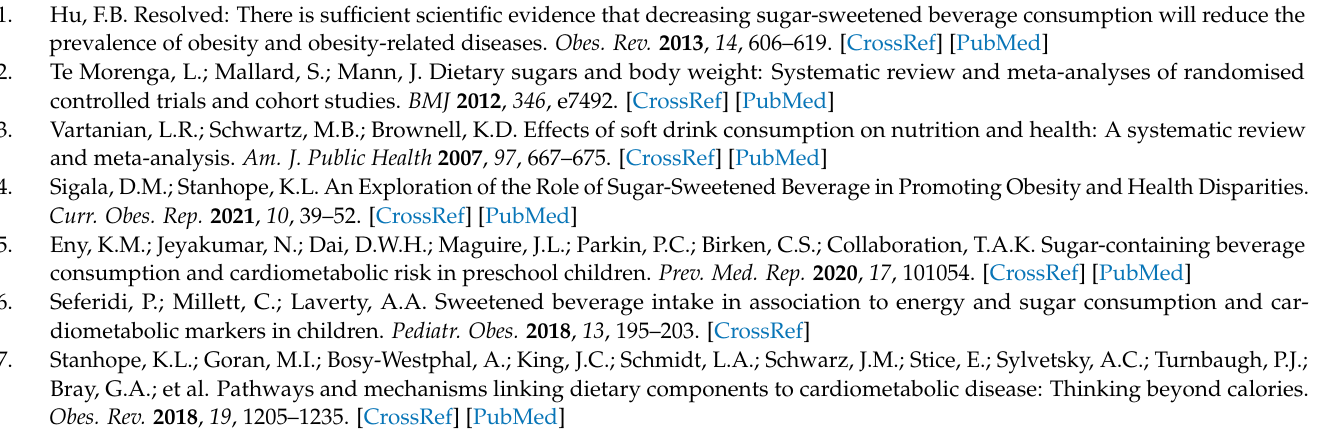
Table S1: Means and standard deviations for the cardiometabolic measures of interest at each visit in childhood and adolescence, Table S2: Prospective associations between all 180 metabolites associated with sugar sweetened beverage intake in childhood (from step 2) and fasting triglycerides across childhood and adolescence, Table S3: Sensitivity Analysis—Prospective associations between select metabolites associated with sugar sweetened beverage intake in childhood and triglycerides across childhood and adolescence with additional adjustment for pubertal